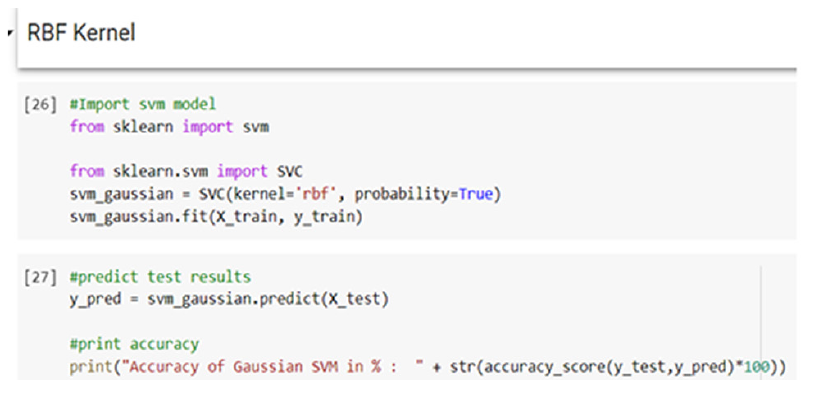
Fig. 4. SVM kernels